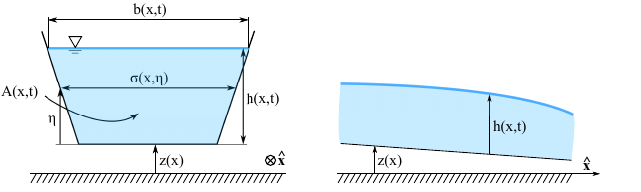
Figure 1. Coordinate system for shallow water equations.